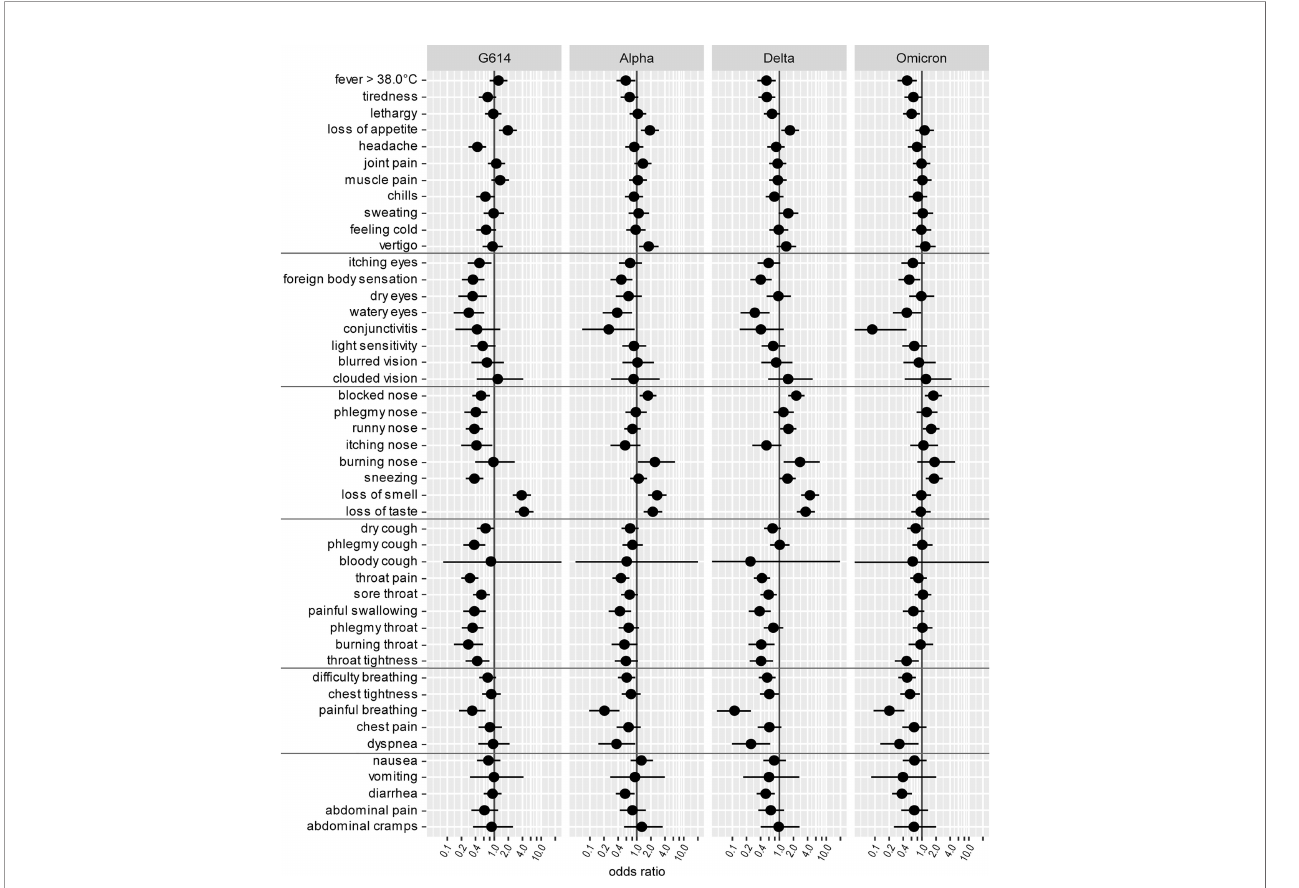
FIGURE 3 | Odds ratios of symptoms. Odds ratios of symptoms and 90% con fi dence intervals were calculated from frequencies of symptoms in SARS-CoV-2 positive individuals from the G614, alpha variant, delta variant and omicron variant dominated phases of the SARS-CoV-2 pandemic in relation to frequencies of symptoms in symptomatic SARS-CoV-2 negative